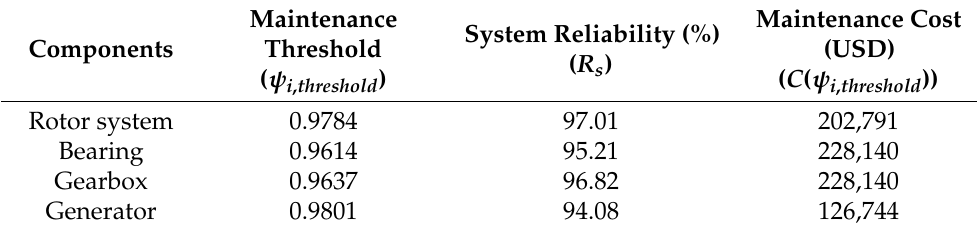
Table 4. The parameters and maintenance costs of